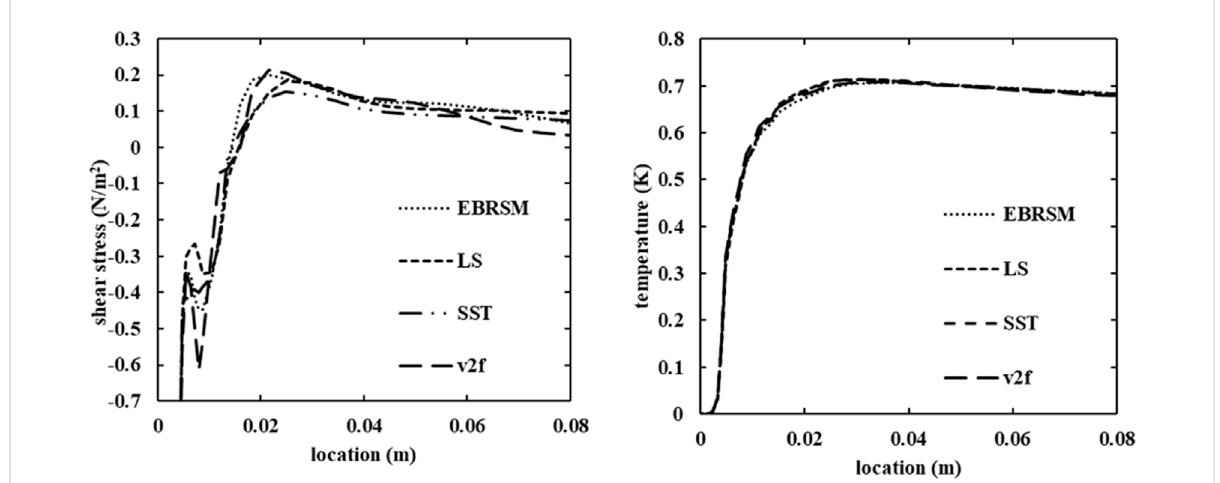
FIGURE 9 Wall shear stress and temperature along the near side wall of the main pipe in the simulations using different turbulence models.